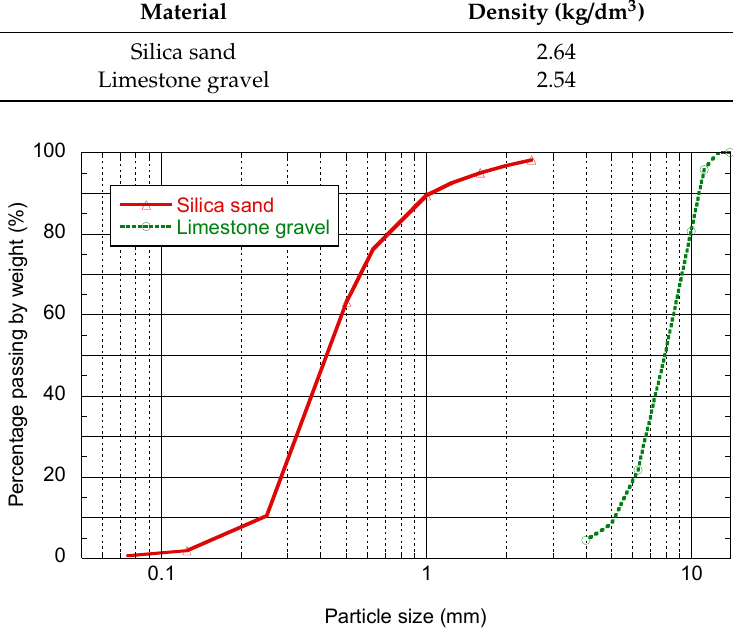
Figure 1. Aggregate grading curves.